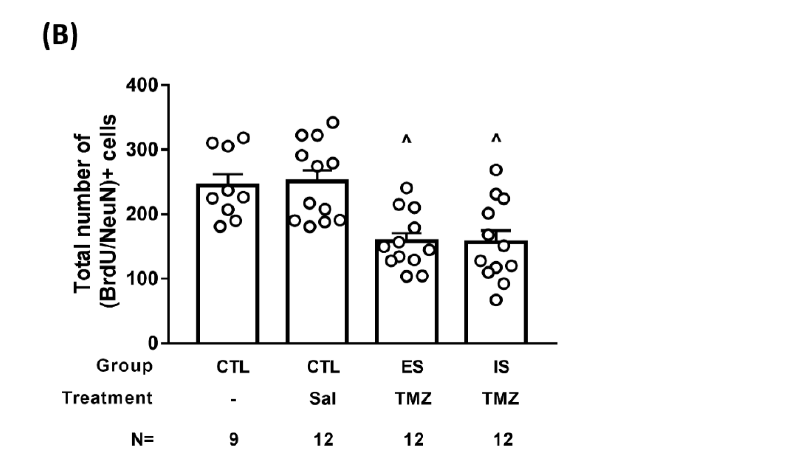
Figure 6. TMZ treatment and object location memory at 6 weeks after the conclusion of the 10-day stressor regimen. ( A ) ES–IS dyads received three daily TMZ injections (25 mg/kg each), while non-stressed control (CTL) mice received an equivalent amount of saline injections or no injection on days 4–6 of the 10-day stressor regimen. ES and IS mice performed comparable recognition ratios on two consecutive days of the trial, and both were lower than the non-stressed controls receiving saline or no injections. ˆ Significantly lower than non-stressed groups receiving saline or no injections. Four groups of mice demonstrated indistinct amounts of time spent in object exploration. ( B ) TMZ-treated ES and IS mice had a lower number of dorsal DG (BrdU/NeuN)+ cells than non-stressed control mice. ˆ Significantly lower than the non-stressed